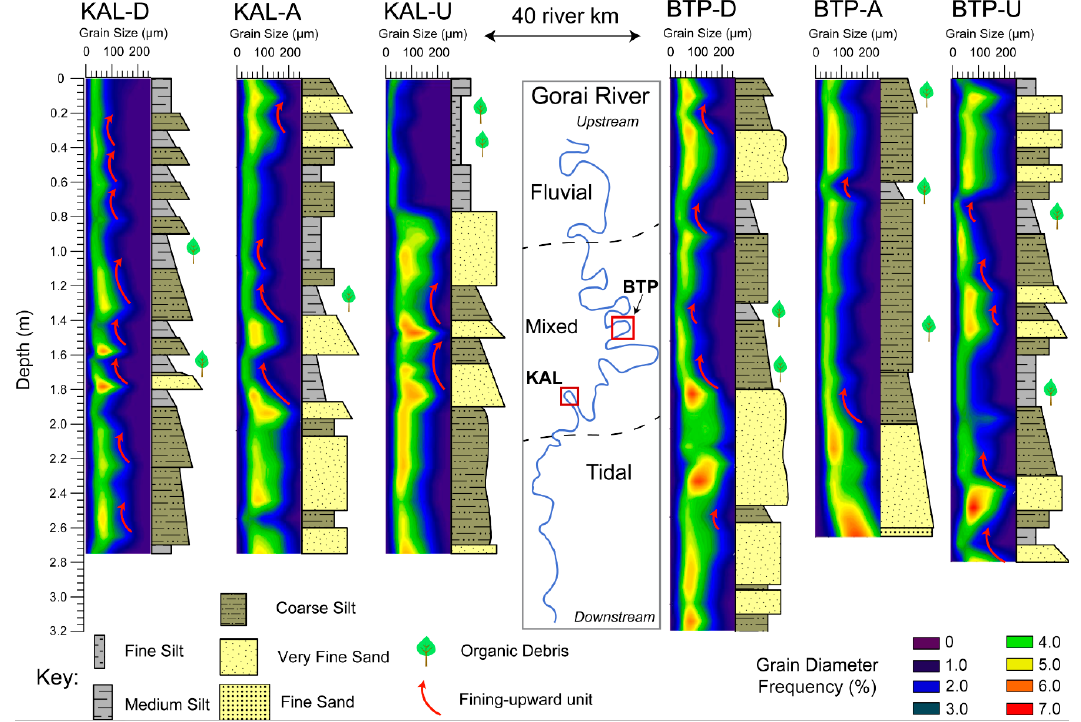
Figure 7. Core stratigraphy at Kalia (KAL) and Bhatiapara (BTP) locations, both of which are situated within the mixed tidal-fluvial depositional realm (mean tide range at KAL and BTP are ~1.8 m and ~1.4 m, respectively). Note the abundance of dm-scale fining-upward units, which are interpreted to represent monsoonal flood deposits.